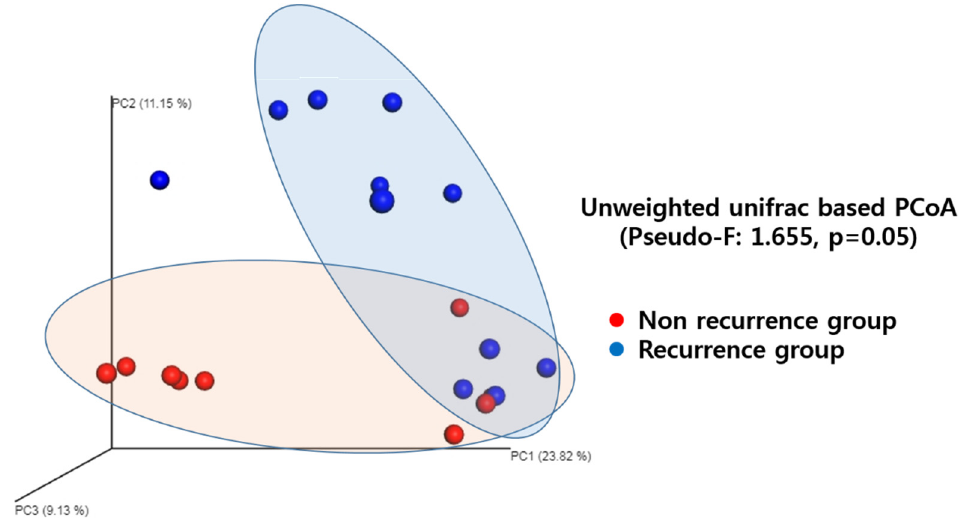
Figure 3. Comparison on community similarity. The unweighted uniFrac distance metric shows difference in microbial communities between the non-recurrence group and recurrence group.